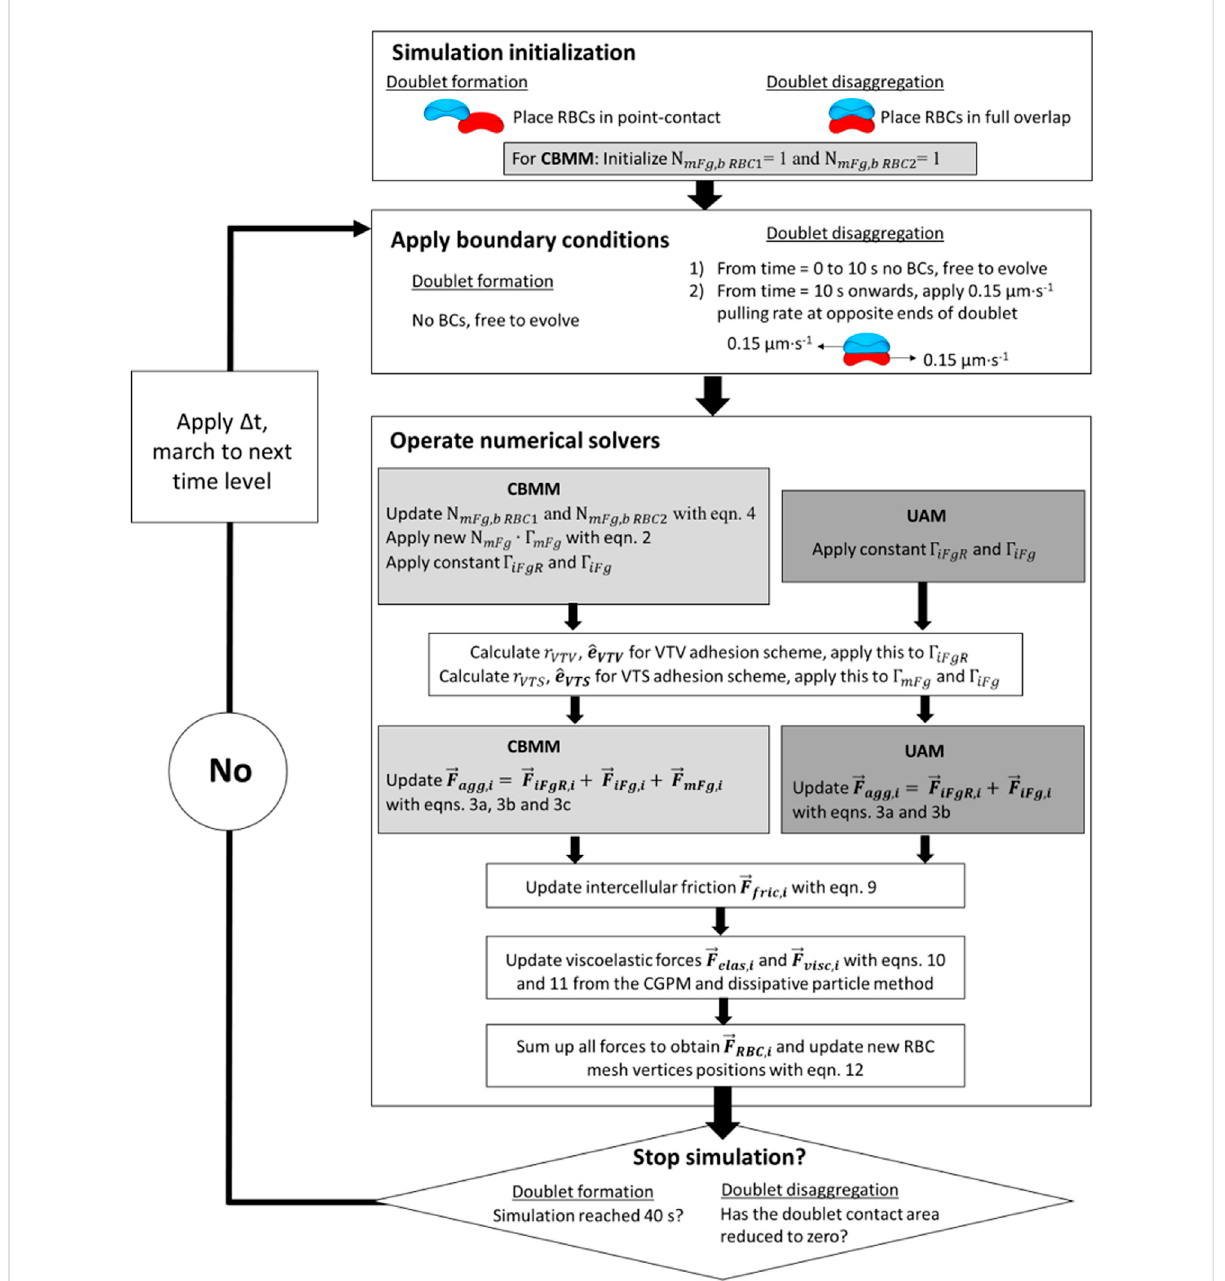
FIGURE 3 Block diagram for fl ow of simulation procedures in the aggregate formation simulations and doublet disaggregation simulations.